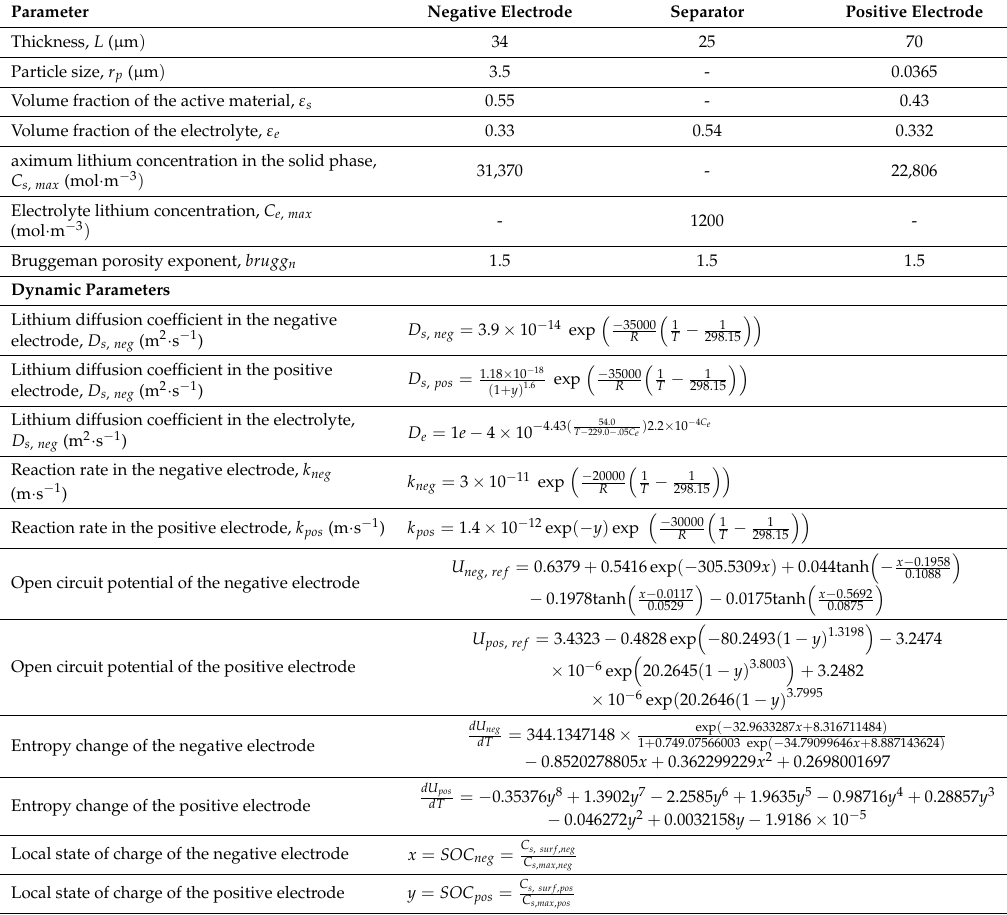
Table A1. Electrochemical parameters applied for modelling of the 10 Ah LFP pouch cell.